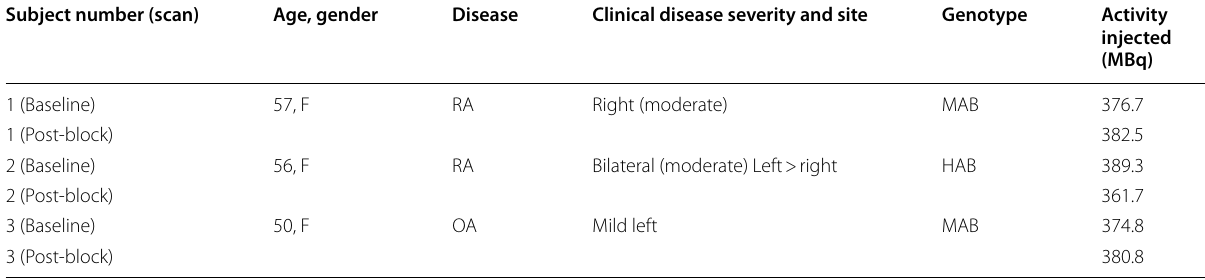
Table 1 Demographics, disease extent, genotype and activity of [ 11 C]PBR28 administered for subjects